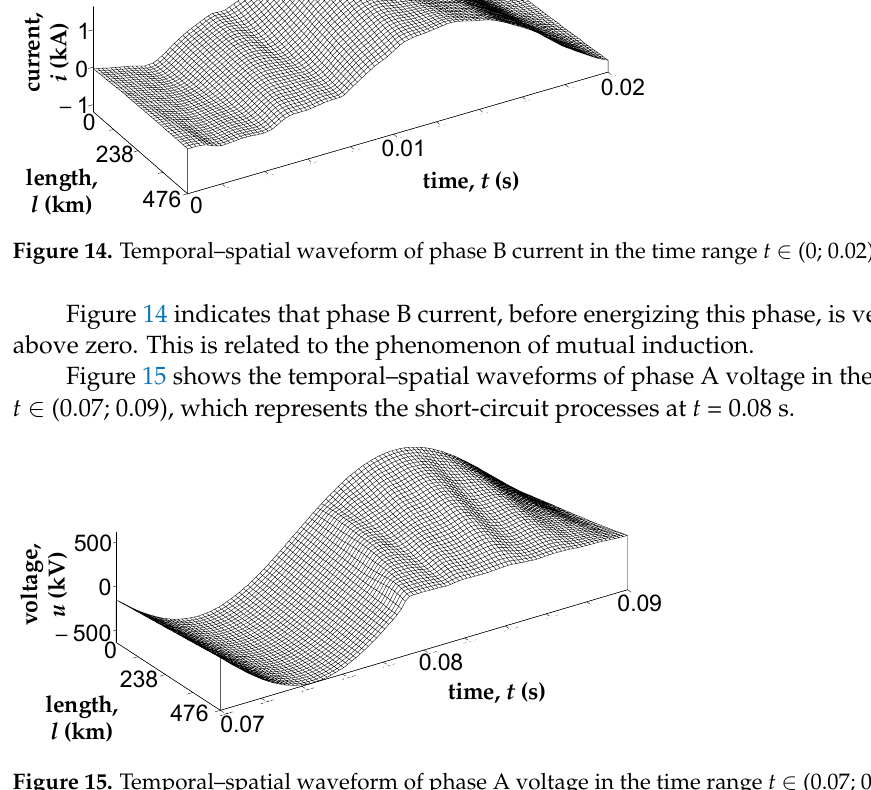
Figure 14 includes a temporal–spatial waveform of phase B current in the time range t ∈ (0; 0.02) s.